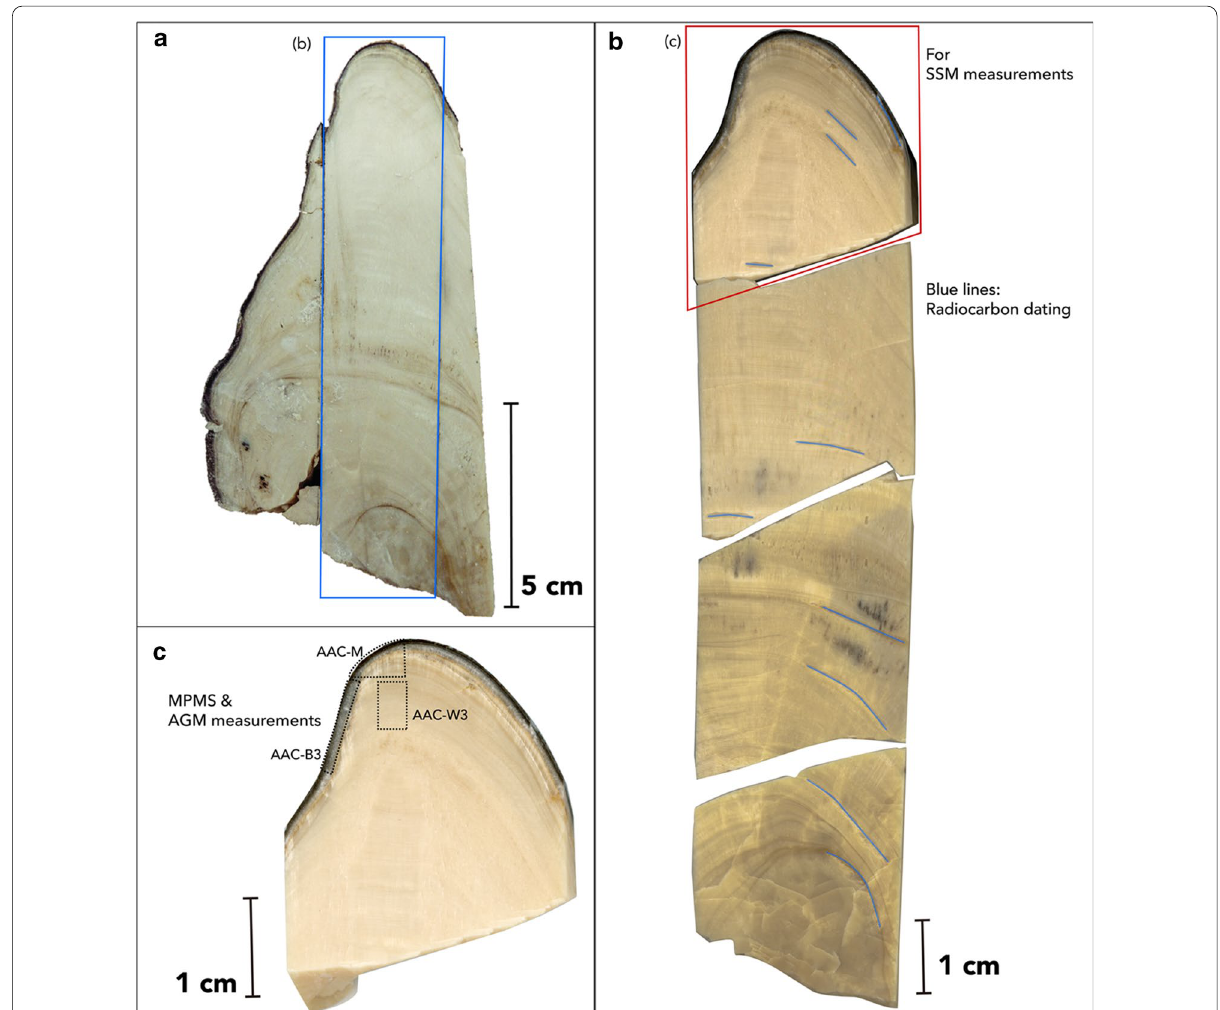
Fig. 1 a Photo of a half-split sample of a speleothem; b SSM measurements and 14 C dating; and c MPMS and AGM